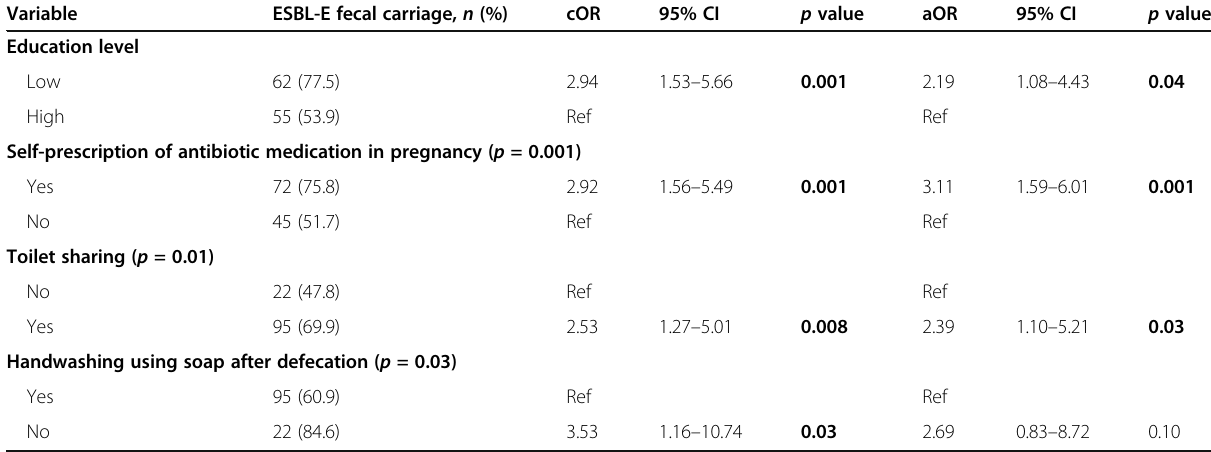
Table 4 Multivariate logistic regression for the factors independently associated with ESBL-E fecal carriage Variable ESBL-E fecal carriage, n